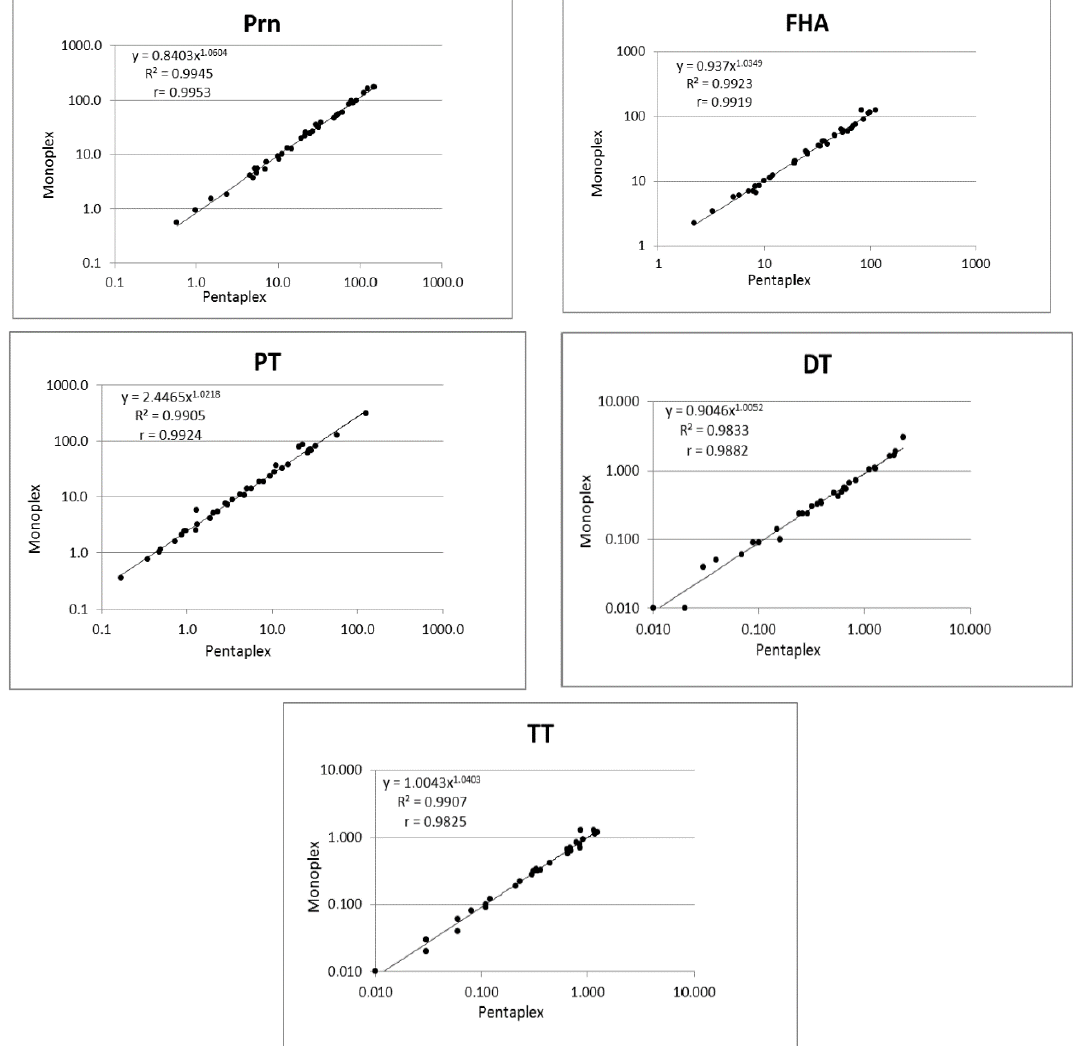
Figure A1. Correlation of anti-Prn, anti-FHA, anti-PT, anti-DT and anti-TT IgG concentrations (IU/mL) of a small serum panel ( n = 37) as detected by monoplex and pentaplex assay. R 2 represents the linear regression coefficient obtained using Microsoft Excel, and r represents the non-parametric Spearman correlation coefficient as calculated with GraphPad Prism Version 6 ( p < 0.0001 for all five analytes).